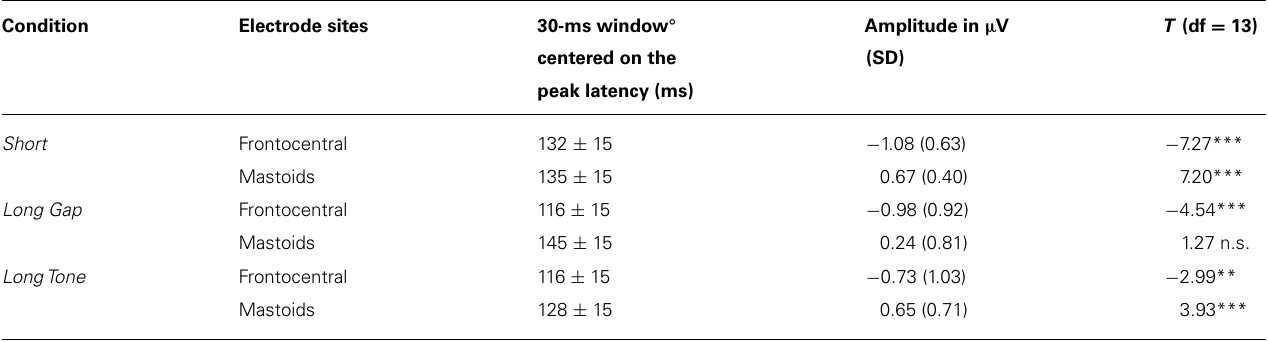
Table 1 | Mean MMN amplitudes measured at frontocentral (FC1, Fz, FC2) or mastoid sites (LM, RM), respectively, and the corresponding statistical results for each